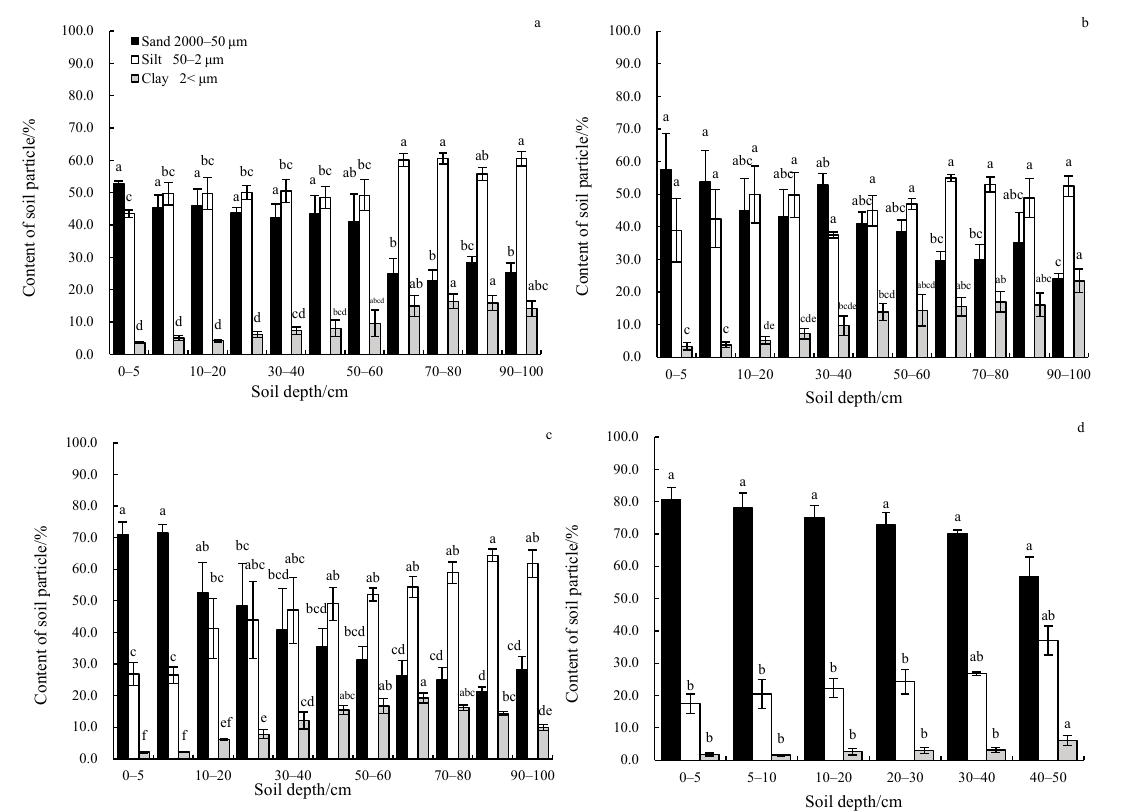
Figure 3. Distribution of soil particles in grasslands in different restoration years (( a – f ) in the figure represent restoration 4a, 5a, 6a, 7a, 8a, and 9a, respectively, the same as below). Notes: The lowercase letters in the figures represent significant differences in the same component at different depths ( p < 0.05).